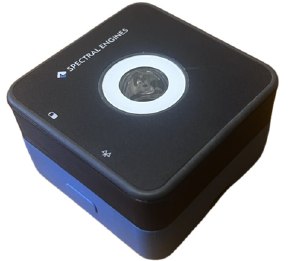
Figure 3. Customized sensor: A 3D printed bracket was adjusted to the sensor to increase the field-of-view.